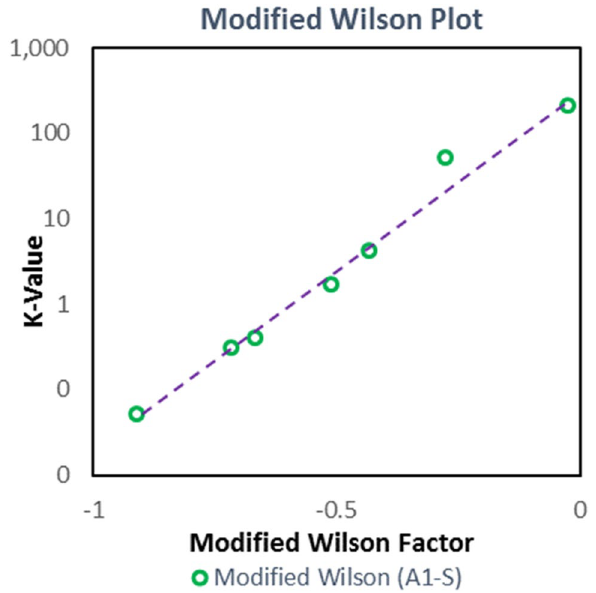
Fig. 20 Valid modified Wilson plot—recombination